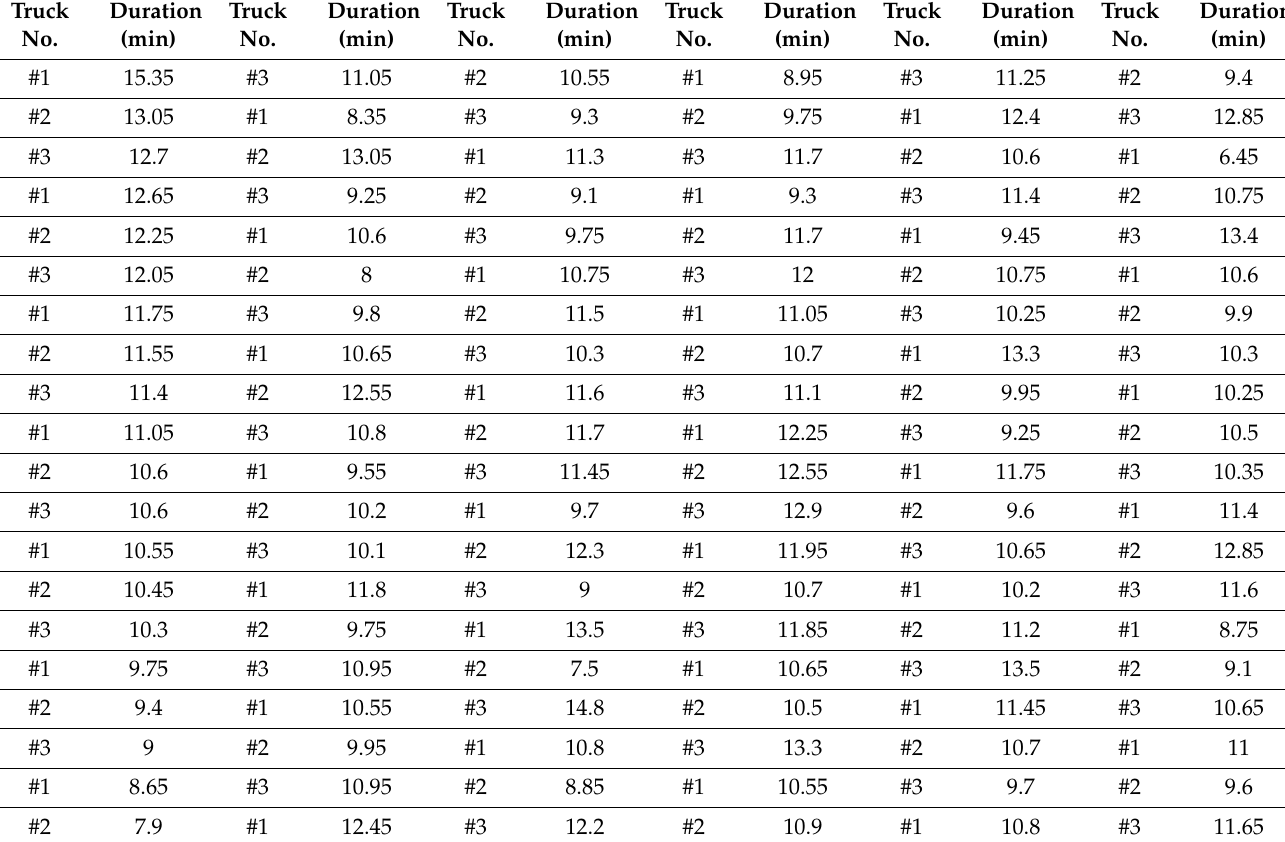
Table 3. Acquired data of the earthwork operation activities (loading